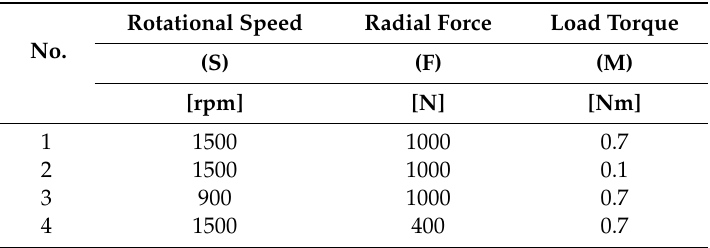
Table 1. Operating Table 1. Operating Conditions.